Question: Looking at the figure, what chart type is it?
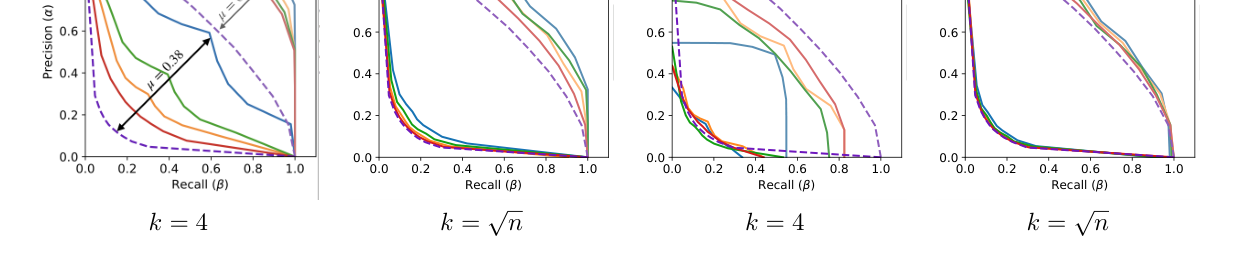
Answer: line